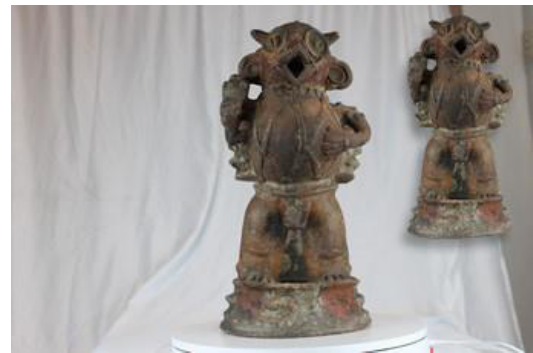
Figure 18. Raw and masked images of a character with bird mask.